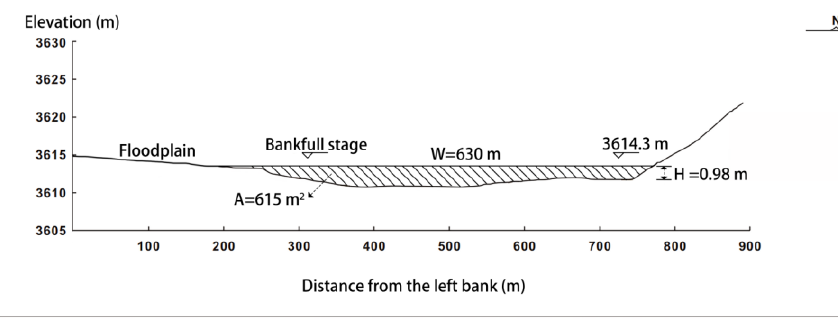
Figure 7. Calculated bankfull channel dimensions at N4 section.